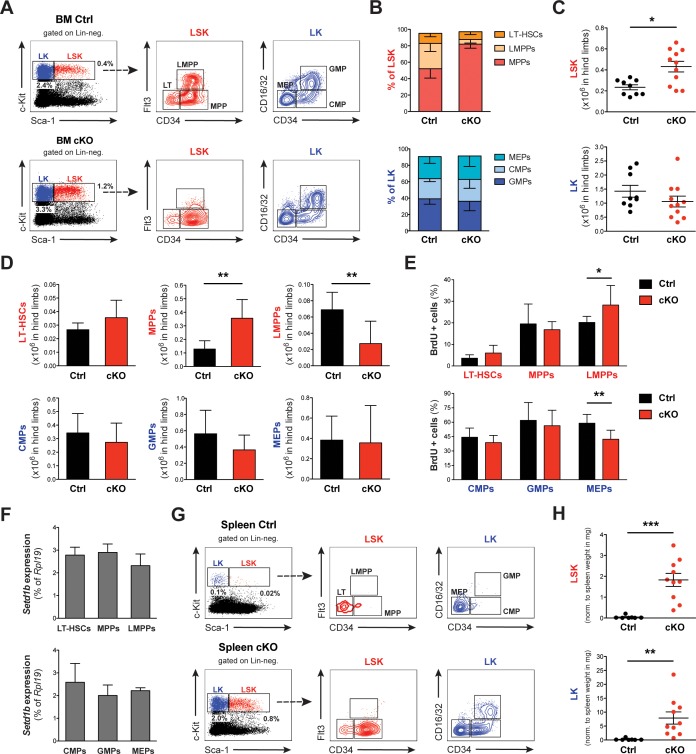
Setd1b-deficiency leads to disturbed HSPC homeostasis in BM and spleen.(A) FACS analysis of hematopoietic stem and progenitor cell (HSPC) populations in BM. The LSK (Lin- Sca-1+ c-Kit+) compartment (depicted in red) is subdivided into LT-HSCs, MPPs, and LMPPs based on differential expression of CD34 and Flt3. The LK (Lin- Sca-1- c-Kit+) population (depicted in blue) divides into CMPs, GMPs, and MEPs based on differential expression of CD34 and CD16/32. The given percentages are relative to total cells analyzed. (B) HSPC ratios 7–25 weeks after tamoxifen induction (Ctrl n = 9, cKO n = 11). The LSK ratio in cKO BM shifted toward a higher percentage of MPPs at the expense of LMPPs. (C) Quantification of FACS data with respect to total cellularity in both hind limb bones (x106). In cKO BM, the LSK compartment has roughly doubled (p*=0.011). (D) This increase resulted from an enriched pool of MPPs (p**=0.001), while LMPPs were significantly reduced (p**=0.006). Of note, none of the myeloid progenitor populations were majorly affected. Data in (B–D) are representative of six independent experiments. (E) BrdU proliferation assay 6 hr after injection (Ctrl n = 7, cKO n = 7). Only in case of LMPPs (p**=0.038) and MEPs (p**=0.007) minor changes were detected in cKO BM. The data were derived from five independent experiments. (F) qRT-PCR analysis of Setd1b expression. Similar levels of Setd1b mRNA were detected in all FACS-sorted HSPC populations from WT mice (n = 3) relative to Rpl19 expression. (G) FACS analysis of HSPCs in the spleen. Other than in controls, the c-Kit + compartment was highly enriched in cKO spleens, indicating fully active hematopoiesis. The given percentages are relative to total cells analyzed. (H) Quantification of FACS data normalized to spleen weight (mg) 7–25 weeks after induction (Ctrl n = 7, cKO n = 10). Both LSK (p***<0.001) and LK compartments (p**=0.001) were significantly increased in cKO spleens. The data are representative of six independent experiments. The graphs in (B) and (D)-(F) depict the mean ± SD; in (C) and (H) the mean ± SEM is provided.10.7554/eLife.27157.011Figure 4—source data 1.Numerical data used to generate Figure 4B,C and D (HSPCs BM RC).